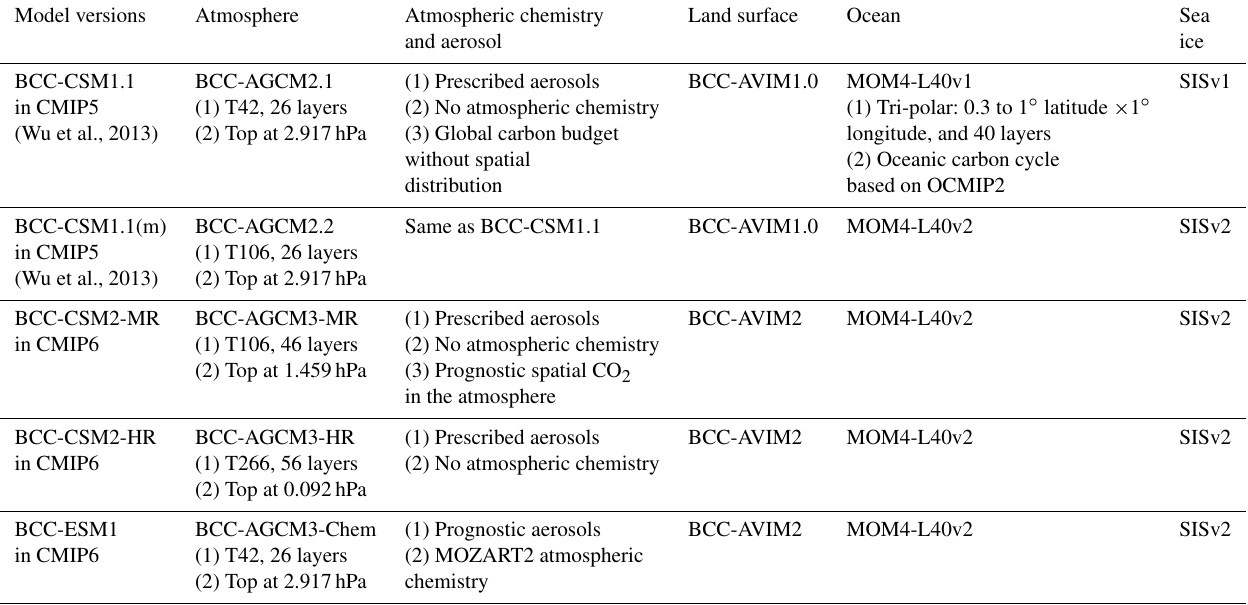
Table 1. BCC models for CMIP5 and